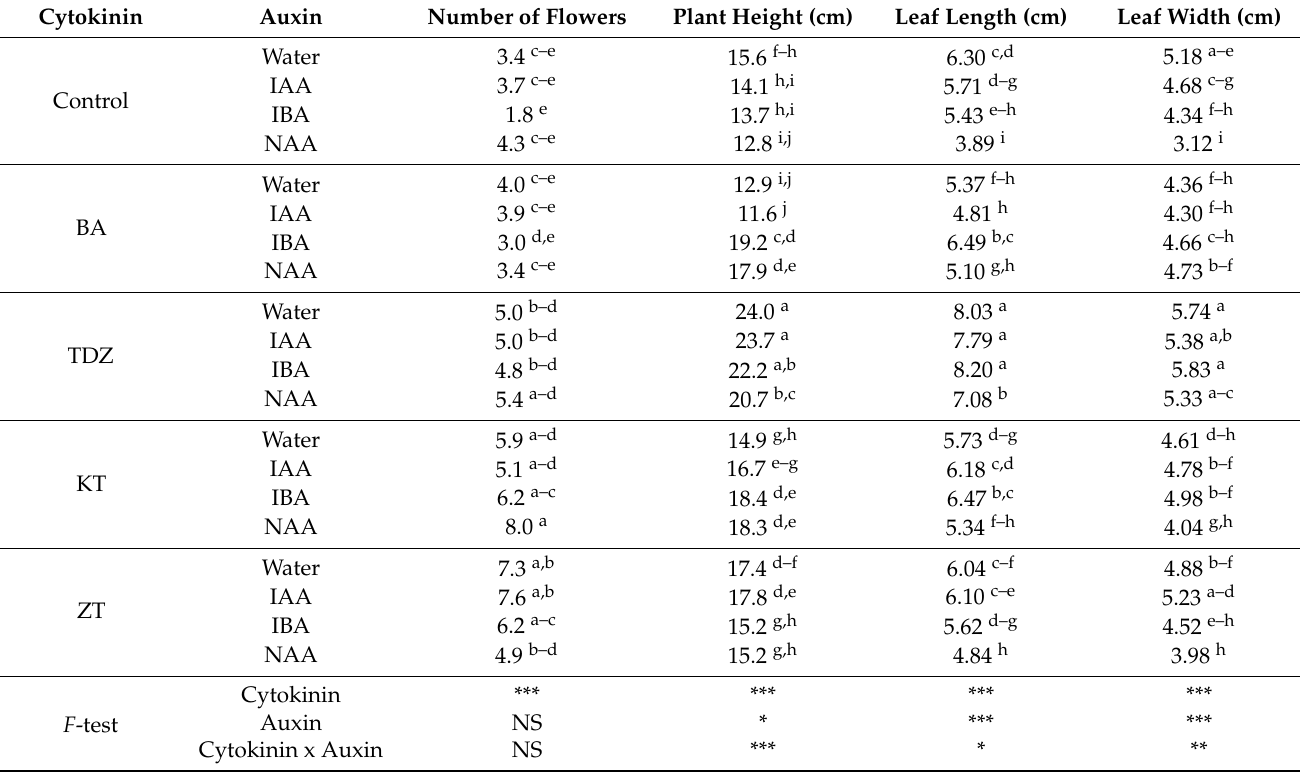
Table 2. The effect of cytokinin and auxin on the growth of strawberry